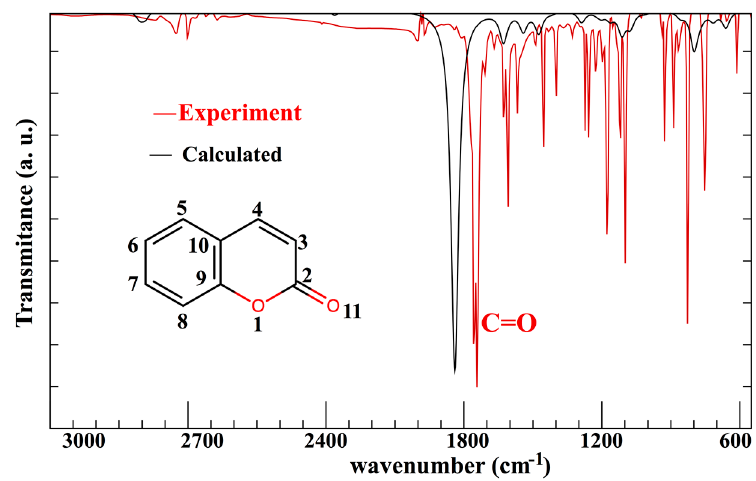
Figure 3. Infrared spectrum of coumarin experimental and calculated (B3LYP / 6-3 1 1 + G*) is shown here.